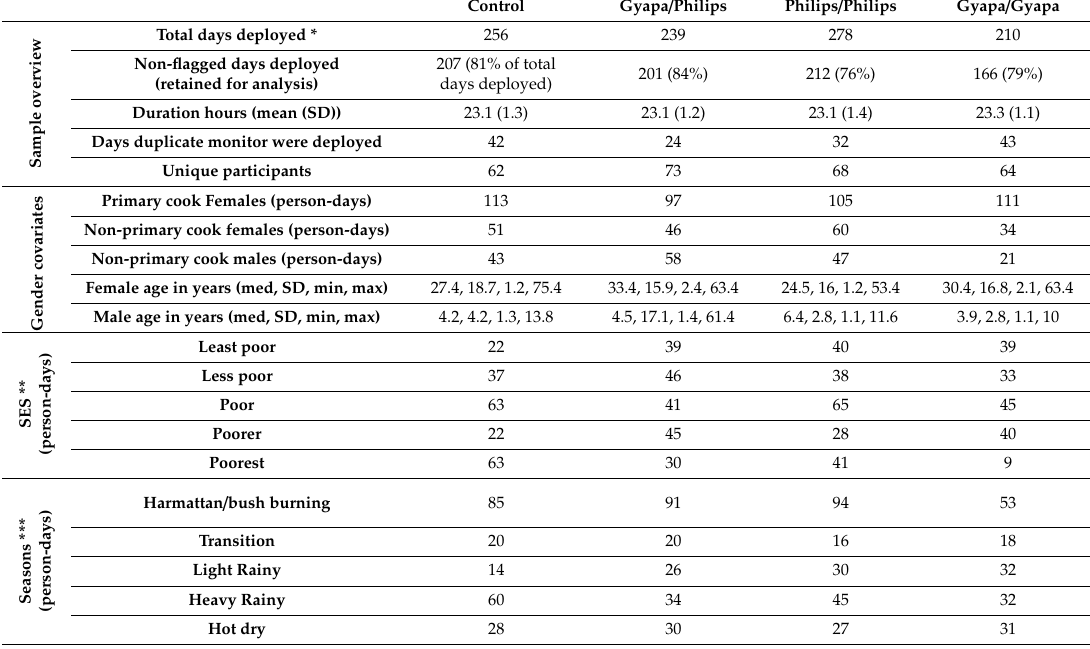
Table 1. Sample statistics for the personal CO exposure deployments throughout research of emissions, air quality, climate, and cooking technologies in Northern Ghana (REACCTING). Control Gyapa / Philips Philips /